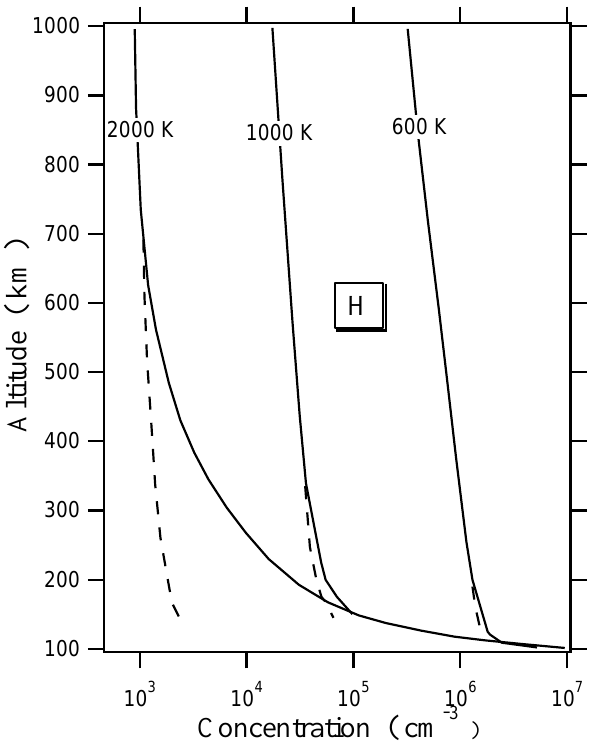
Fig. 9. Atomic hydrogen vertical distributions for three ther- mopause